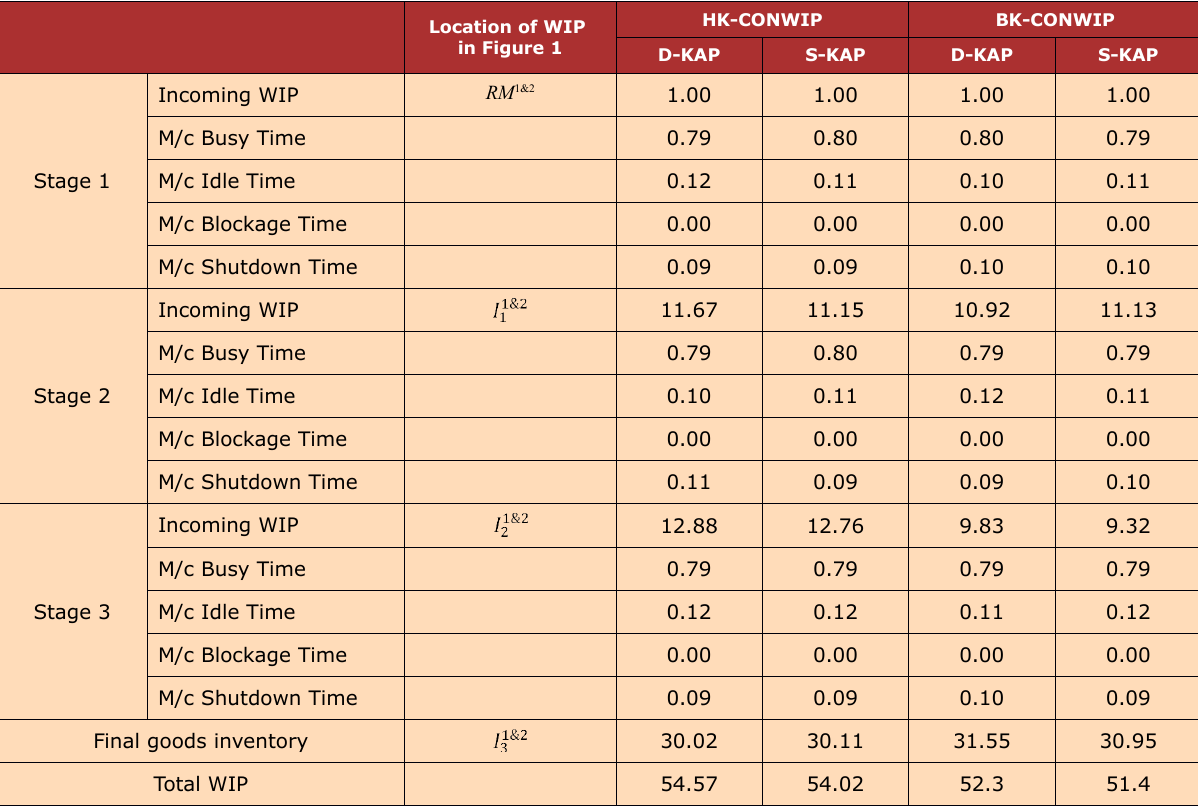
Table 13. Case 1 stage state statistics of PCS+KAP at targeted 100% service